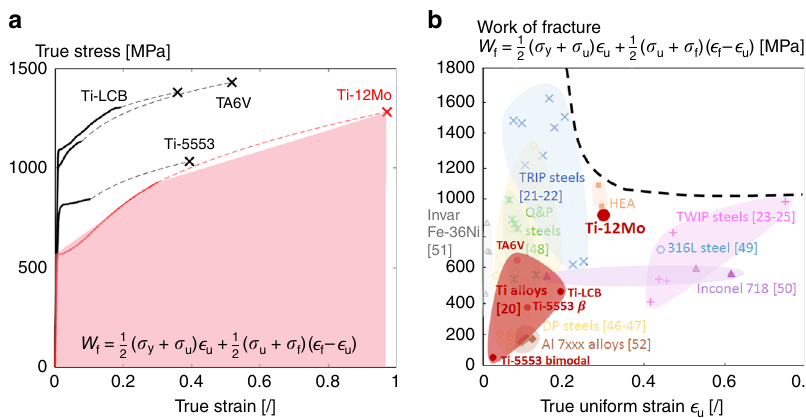
Fig. 1 Post-necking properties of the Ti-12Mo (wt.%) alloy compared with other high strength alloys 20 – 25,46 – 52 . a True stress-true strain curves of Ti- 12Mo compared with classical Ti alloys. A cross indicates the true fracture stress and true fracture strain. A dashed line represents the extrapolation between the true tensile curve recorded up to necking and the true fracture stress — true fracture strain. The red colored area represents the integration performed to estimate the work of fracture W , which is used as an indicator of the fracture toughness. b Comparison of the work of fracture W f true uniform strain ϵ of several alloys. The major families of alloys are grouped by colored circles. A black dashed line indicates the limit of the best u combination of both properties. Ti-12Mo alloy is located among the best materials on the map, while its outstanding mechanical properties with respect to classical Ti alloys are clearly demonstrated. The mechanical properties of the HEA and some DP steels result from internal unpublished PhD